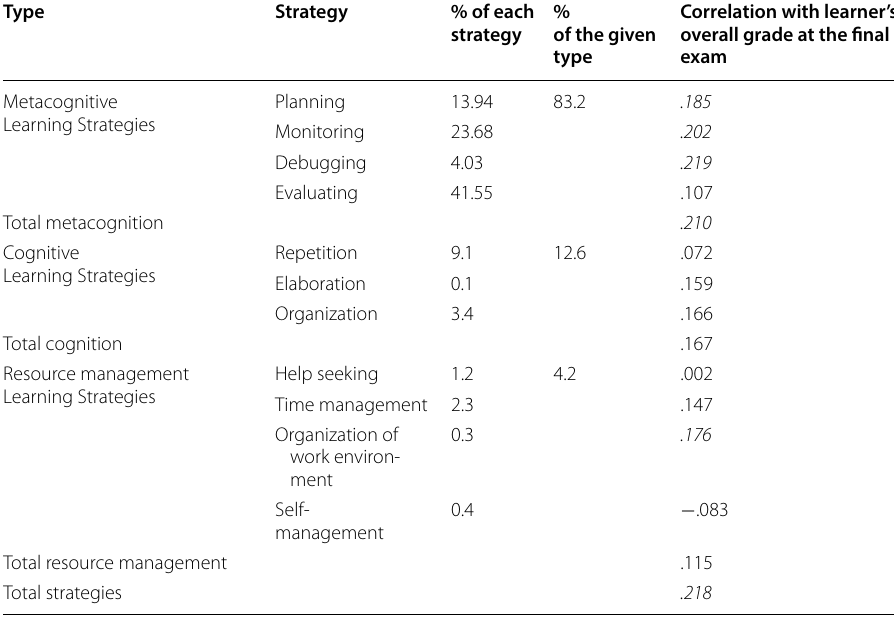
Italic values indicate significance of p value ( p <